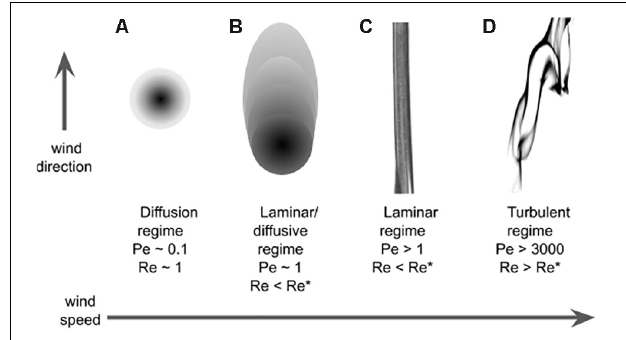
FIGURE 3 | Plume structure. Regimes that are qualitatively different for increasing value of wind speed. The regimes are identified for different values of Péclet and Reynolds numbers: (A) Diffusive regime, (B) laminar/diffusive regime, (C) laminar regime, and (D) turbulent regime (see text). In this pictorial representation the Schmidt number (Pe/Re) is around